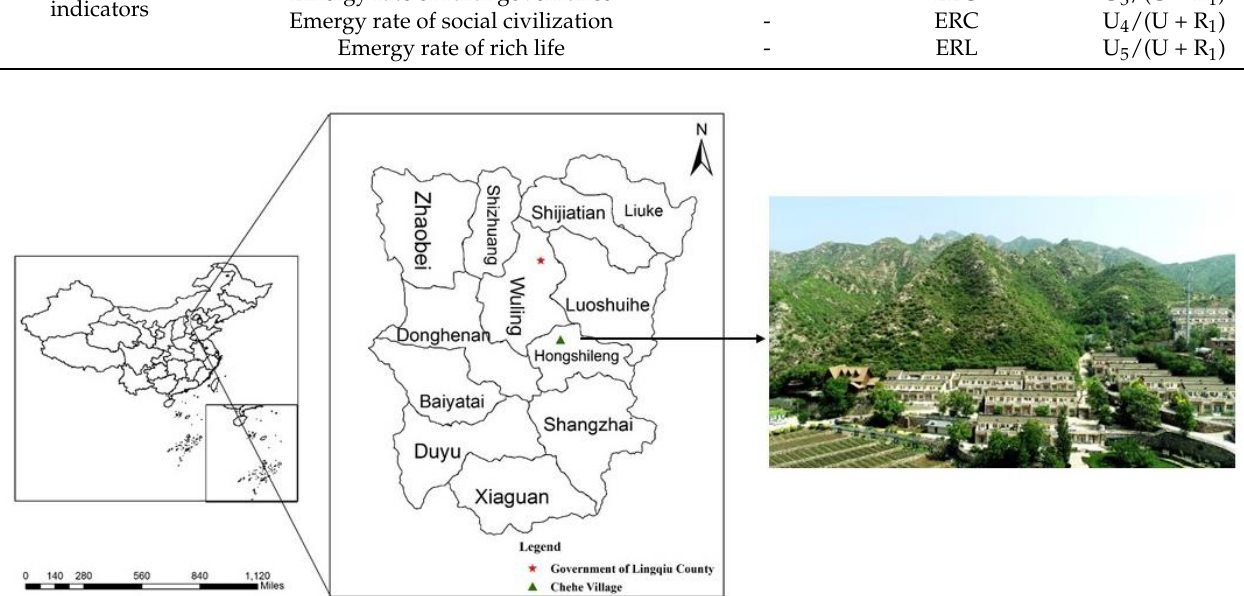
Figure 2. Location of Chehe Village. Note: the first picture in the left is the map of China, the second picture is the map of Lingqiu County, and the third picture is the view of Chehe Village. The location picture of Chehe Village was drawn with Arcgis by the author and the right view picture of Chehe Village is from the website. Website address is http://k.sina.com.cn/article_6433760072_17f7b634800100ot6r.html?wm=3049_0032 (accessed on 18 May